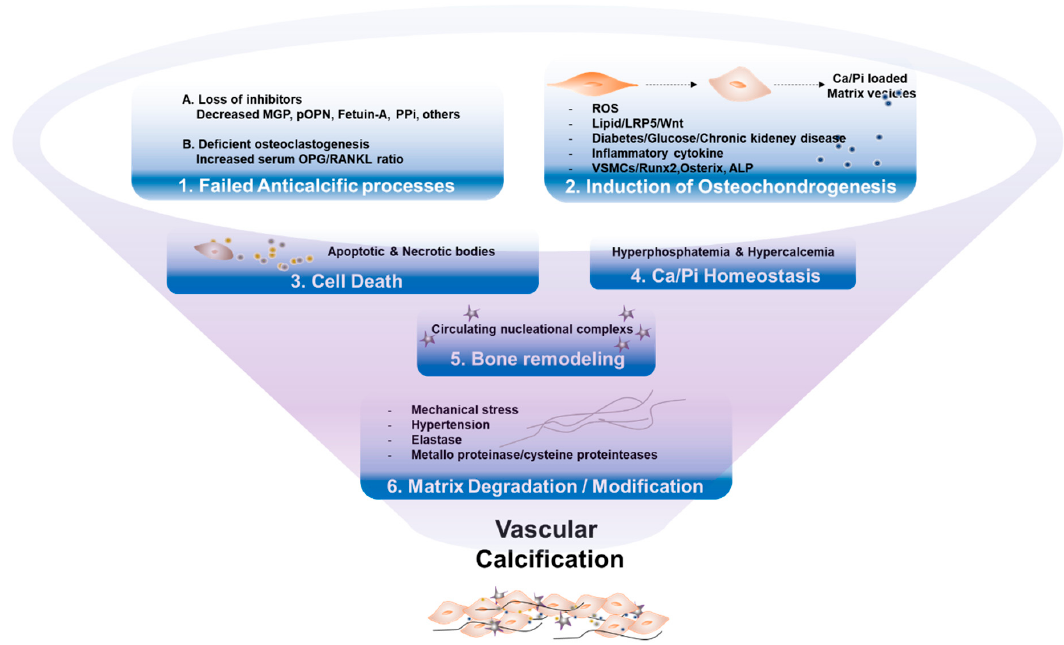
Figure 2. Key mechanisms of vascular calcification. (1) Failure of anti-calcification processes, due to loss of inhibitors and deficiency of constitutively expressed mineralization inhibitors, leads to vascular calcification. (2) Various stressors induce osteogenic transdifferentiation of VSMCs, products of matrix vesicles, which act as a nidus of calcium phosphate deposition. (3) Cell death by apoptosis or necrosis leads to release of apoptotic bodies, or necrotic debris, which may act as nucleation of apatite. (4) Abnormal mineral homeostasis causes deposits calcium phosphate hydroxyapatite. (5) Nucleational complexes formed during bone remodeling, promote ectopic mineralization. (6) Matrix degradation/modifications, caused by environmental stressors, are involved in vascular calcification.